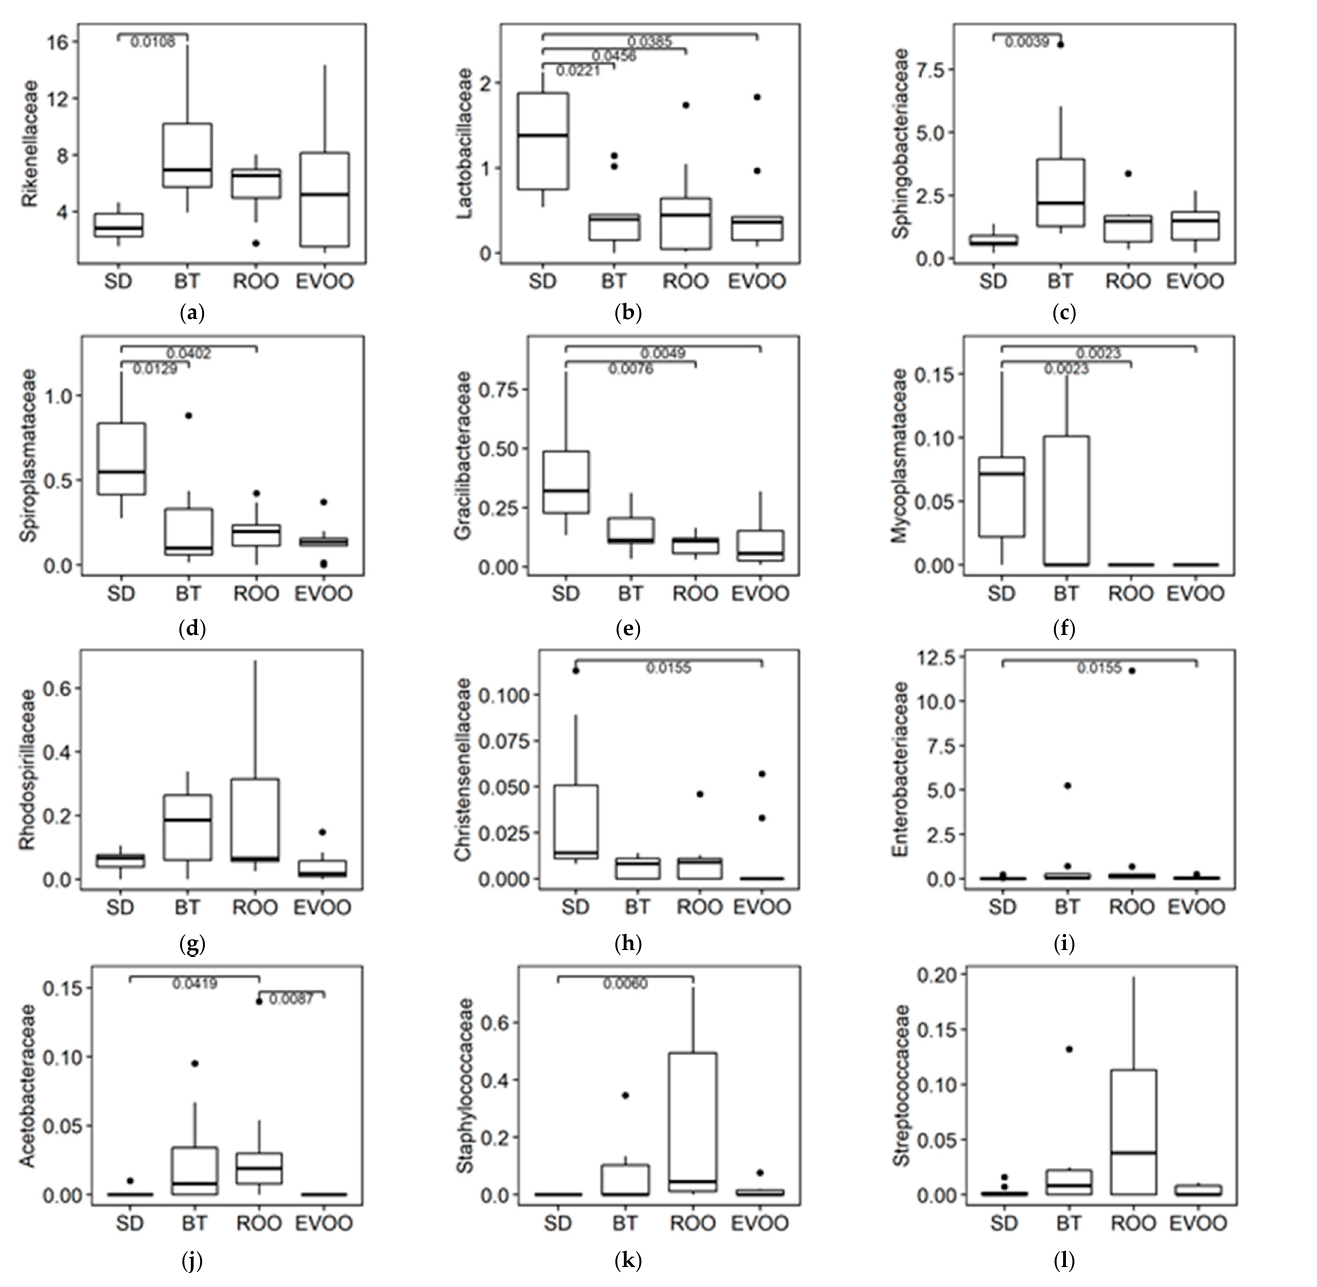
Figure 4. Box plot representation of the percentage distribution of the twelve families ( a ) Rikenellaceae , ( b ) Lactobacillaceae , ( c ) Sphingobacteriaceae , ( d ) Spiroplasmataceae , ( e ) Gracillibacteraceae , ( f ) Mycoplasmatace , ( g ) Rhodospirillaceae , ( h ) Christensenellaceae , ( i ) Enterobacteriaceae , ( j ) Acetobacteraceae , ( k ) Staphylococcaceae , ( l ) Streptococcaceae , with significant differences ( p < 0.05) among fecal samples from mice fed a diet enriched with butter (BT), extra virgin olive oil (EVOO), refined olive oil (ROO), or standard chow (SD). Adjusted p -values of significant pairwise comparisons are also shown. SD, EVOO, and BT diet values from [17].